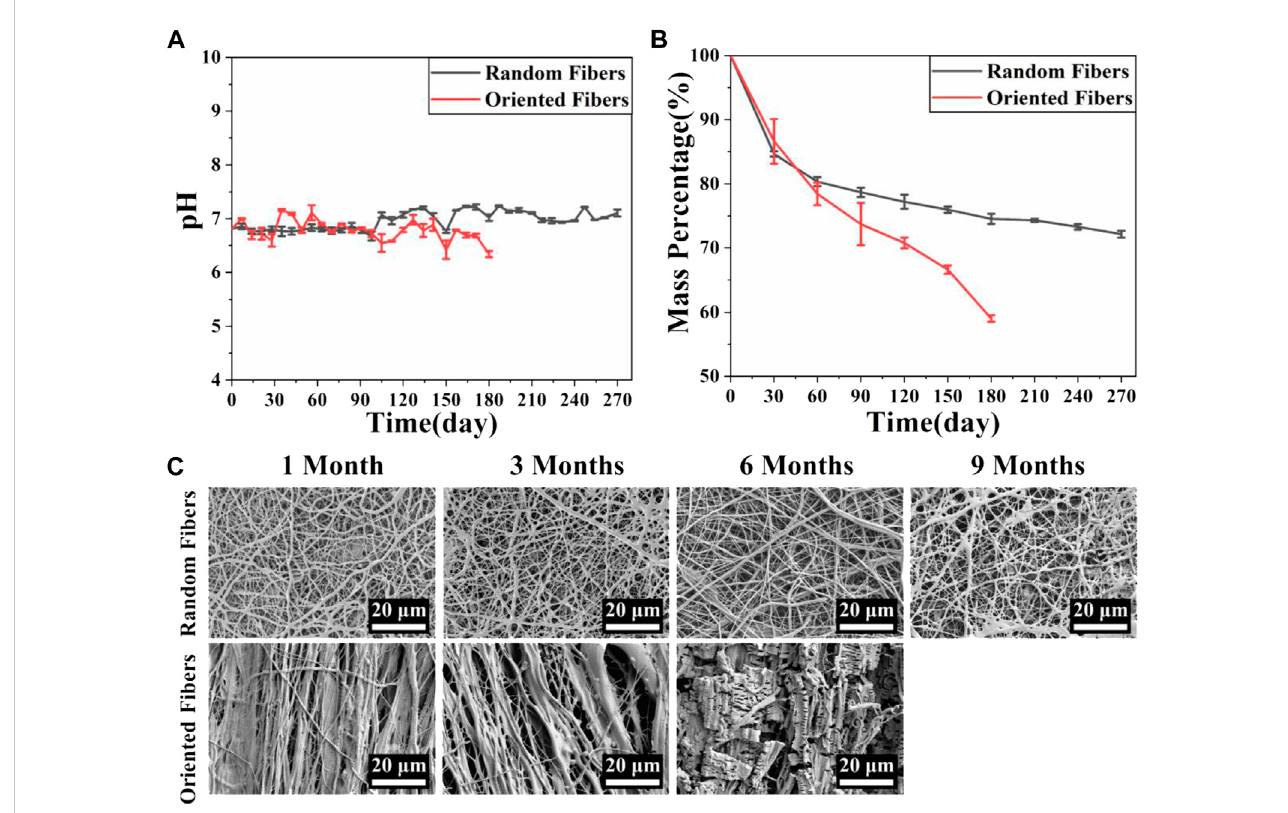
FIGURE 4 Simulation of fi ber membrane degradation behavior in vitro . (A) pH changes during simulated degradation of random- and oriented- fi ber membranes in vitro (N = 3). (B) Mass changes during simulated degradation of random- and oriented- fi ber membranes in vitro (N = 3). (C) Morphological changes during simulated degradation of random- and oriented- fi ber membranes in vitro